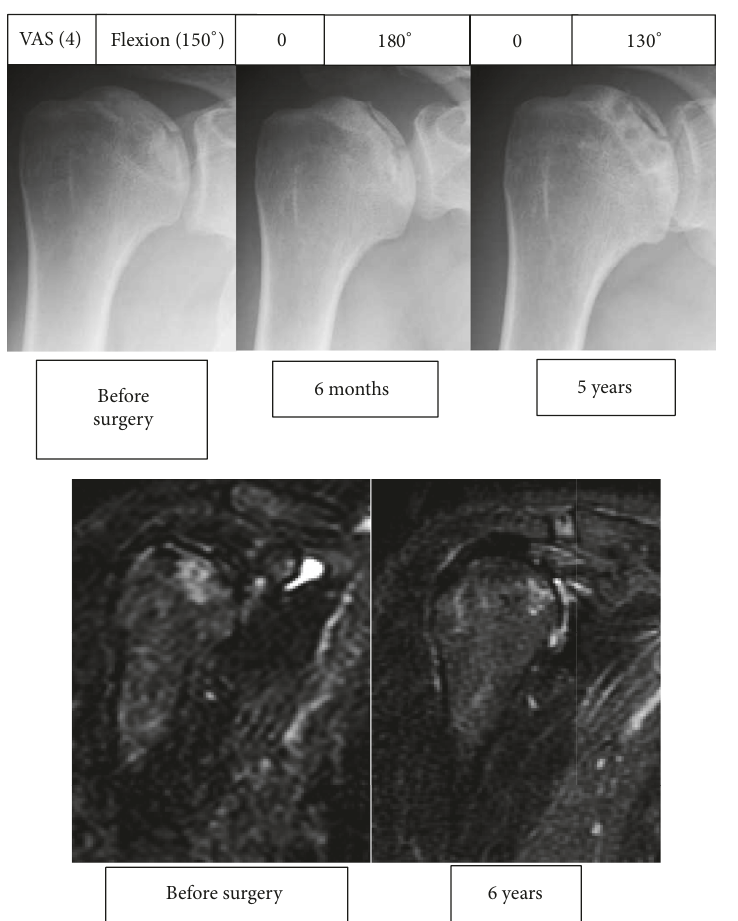
Figure 1: Radiographic and magnetic resonance images of the right shoulder in Case 1 . The box on top of the radiographic images shows the visual analogue scale on the left and the range of flexion on the